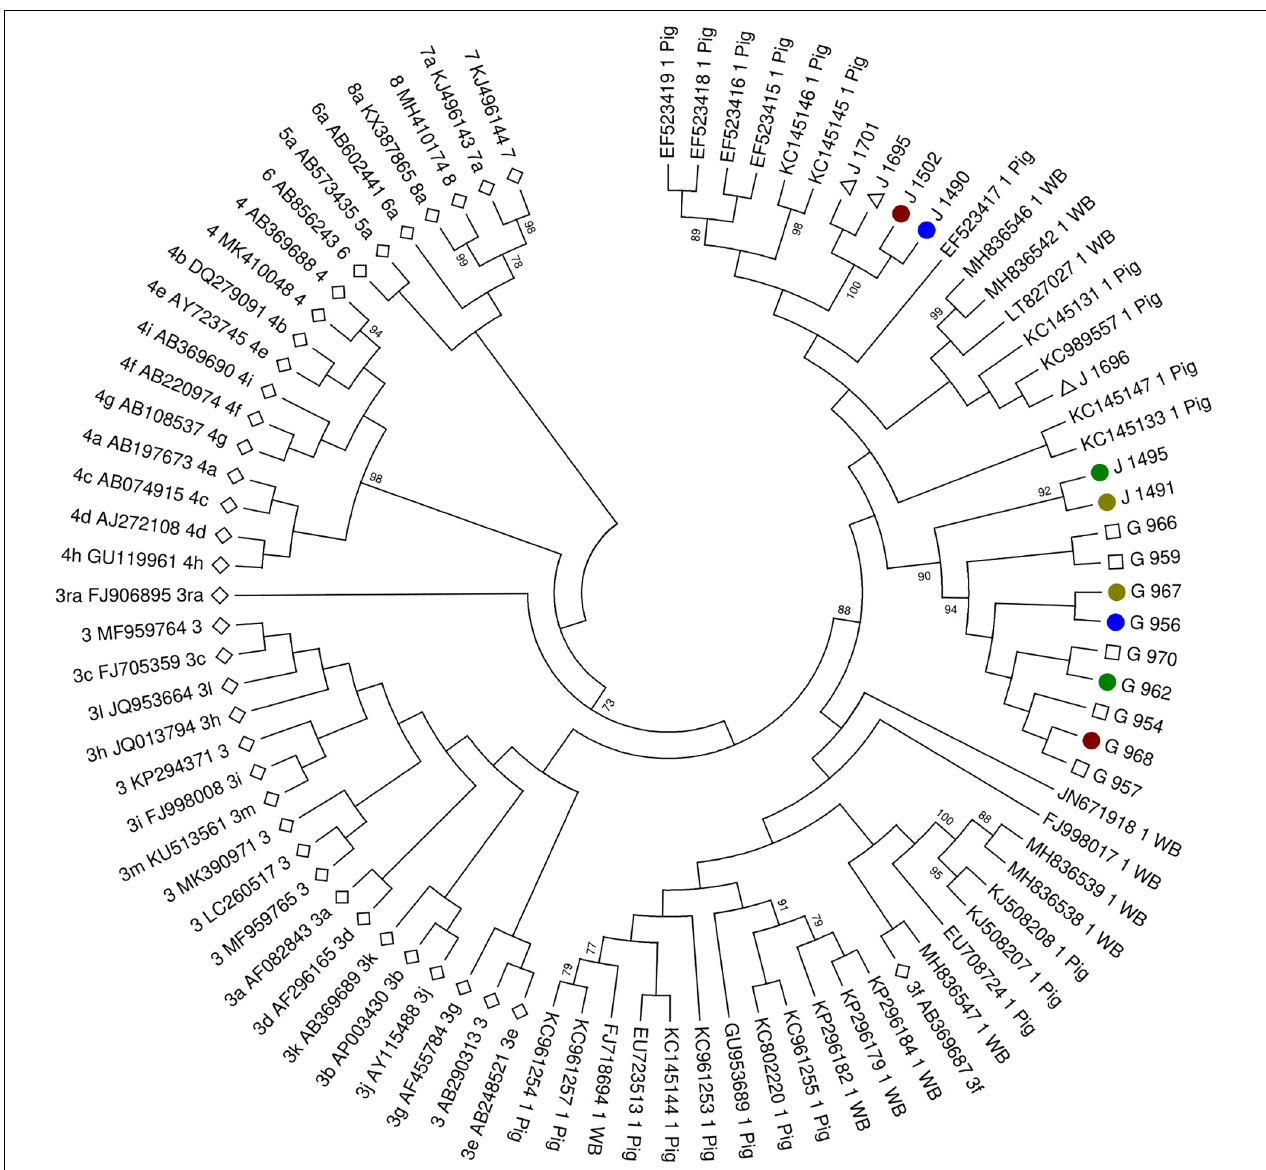
FIGURE 1 | Molecular phylogenetic analysis by maximum likelihood method. White diamond highlights the standard strains proposed by Smith et al. (2020). White triangle highlights wild boar sequences without positive ticks for hepatitis E virus (HEV) RNA. White square highlights tick sequences without positive wild boar for HEV RNA. Colored circles highlight pair wild boar–tick sequences (red for J1502-G968, blue for J1490-G956, dark green for J1495-G962, and light green for J1491-G967). The evolutionary history was inferred by using the maximum likelihood method based on the Tamura-Nei model. The bootstrap consensus tree inferred from 1,500 replicates is taken to represent the evolutionary history of the taxa analyzed. Branches corresponding to partitions reproduced in less than 50% bootstrap replicates are collapsed. Initial tree(s) for the heuristic search were obtained by applying the neighbor-joining method to a matrix of pairwise distances estimated using the maximum composite likelihood (MCL) approach. The analysis involved 88 nucleotide sequences. All positions with less than 95% site coverage were eliminated. That is, fewer than 5% alignment gaps, missing data, and ambiguous bases were allowed at any position. There was a total of 302 positions in the final dataset. Evolutionary analyses were conducted in